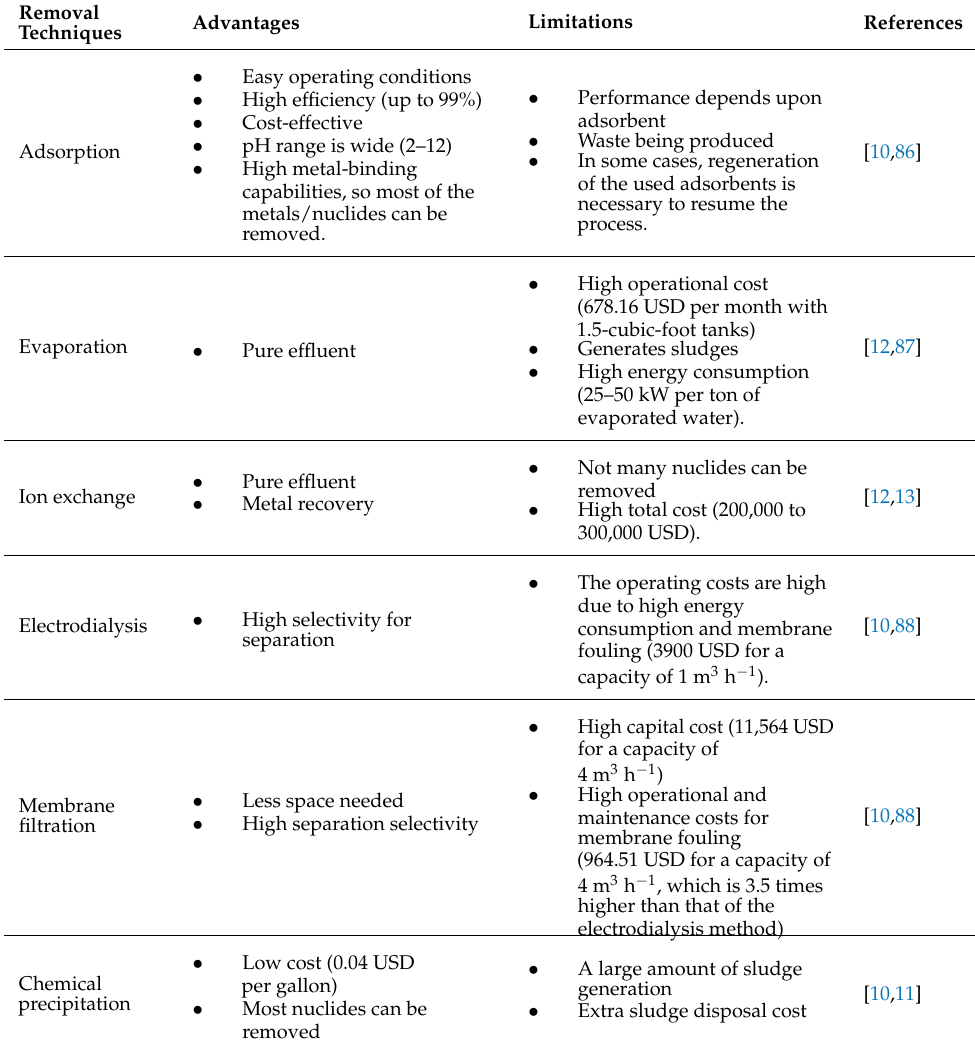
Table 2. Advantages and limitations of different removal techniques.